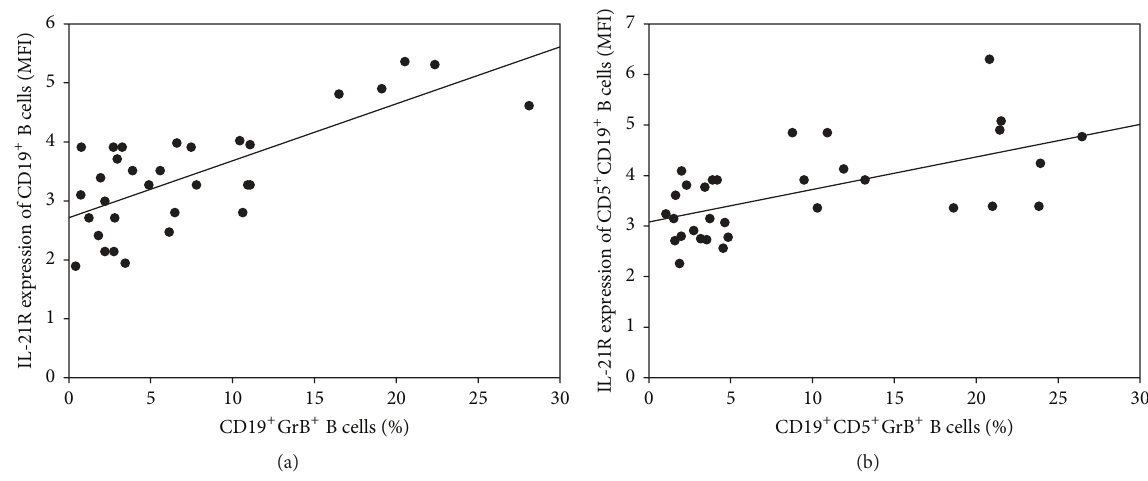
Figure 3: Correlation analysis between granzyme B and interleukin-21 receptor expression in (a) CD19 + B cells ( 𝑅 = 0.6261 , 𝑝 = 0.0001 ) and (b) CD19 + CD5 + B cells ( 𝑅 = 0.5949 , 𝑝 = 0.0003 ).